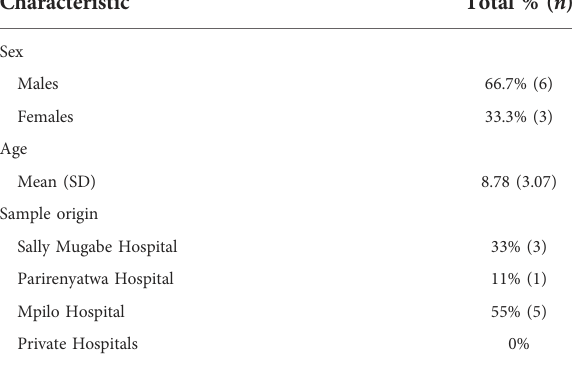
TABLE 1 Participant ’ s characteristics.